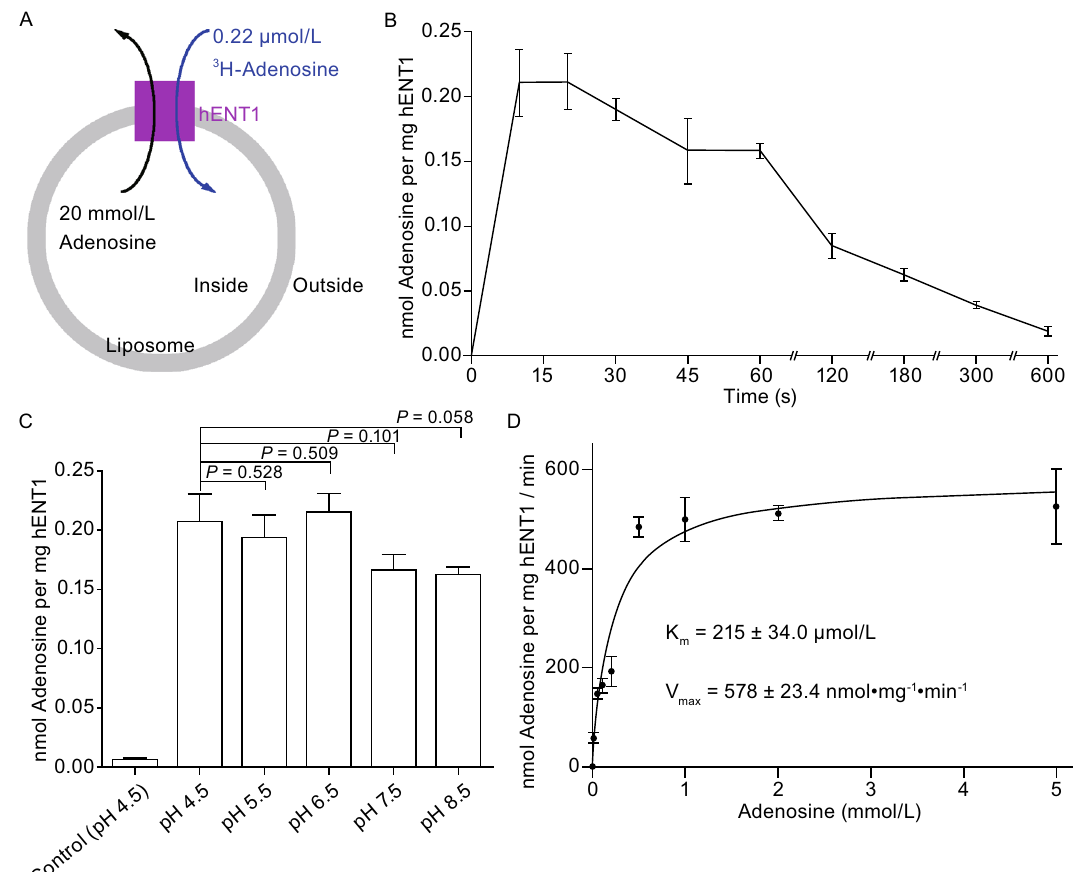
Figure 2. Transport activity of hENT1. (A) A schematic diagram of the counter fl ow assay. Uptake of 3 H-labeled adenosine into the hENT1-incorporated liposome was monitored. (B) A time course analysis of the transport activity of hENT1. (C) The transport activity of hENT1 is pH-independent as measured in the liposome-based counter fl ow assay. P values between different pH values and pH 4.5 are indicated. Control (pH 4.5) refers to the condition where protein-free liposomes were used. (D) Determination of K m and V max for the transport of adenosine by hENT1. hENT1 proteoliposome was incubated in the presence of increasing concentrations of unlabeled adenosine. The K m value was determined by non-linear regression analysis using GraphPad Prism version 5.0 software. Each data point represents the average of at least three independent experiments. The error bars represent standard deviation